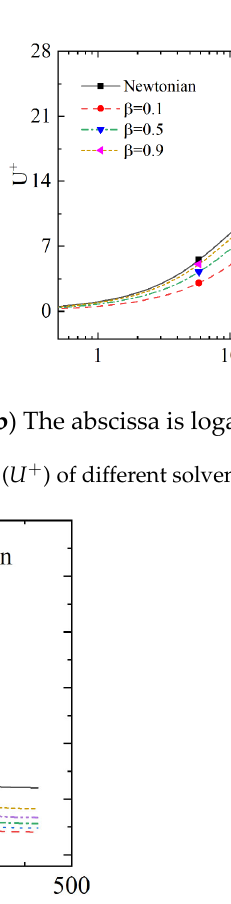
Figure 20. Dimensionless turbulent kinetic energy ( k + ) of different solvent viscosity ratios ( β ).